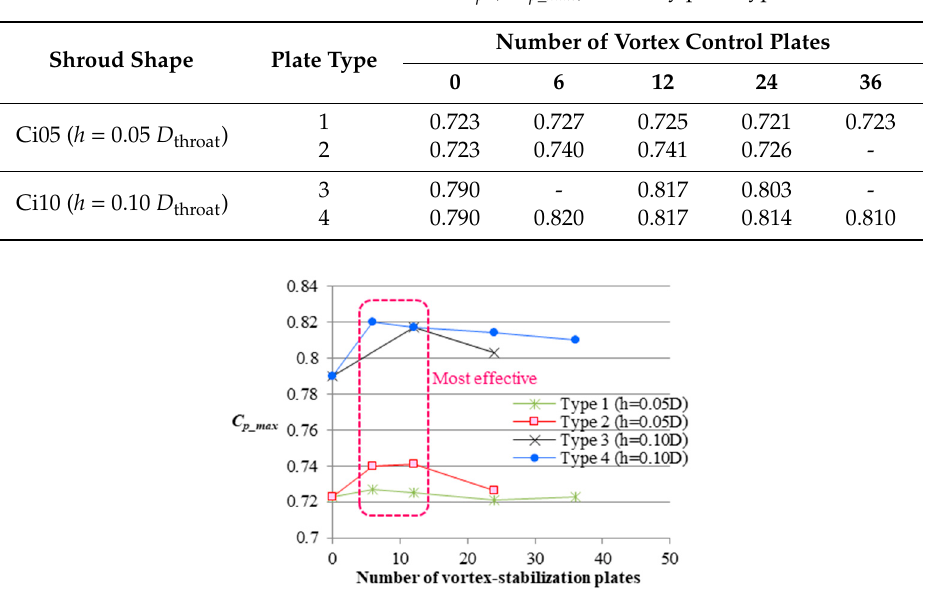
Figure 12. Variations of C p_max with increases in the installed number of vortex stabilization plates. Table 4. The maximum values of C p (= C p_max ) for every plate type.